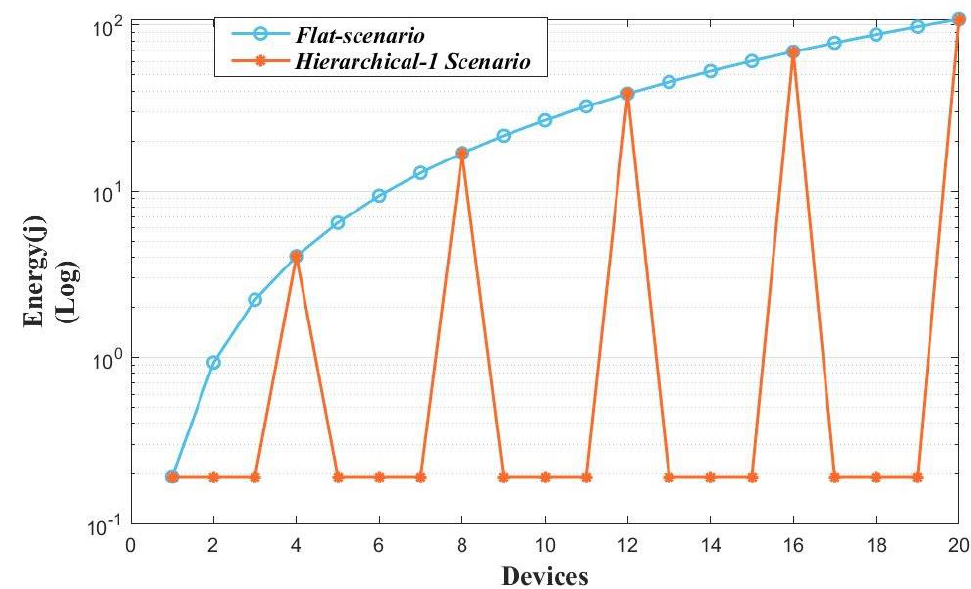
Figure 11. Energy consumption for simple sensors in different topologies.